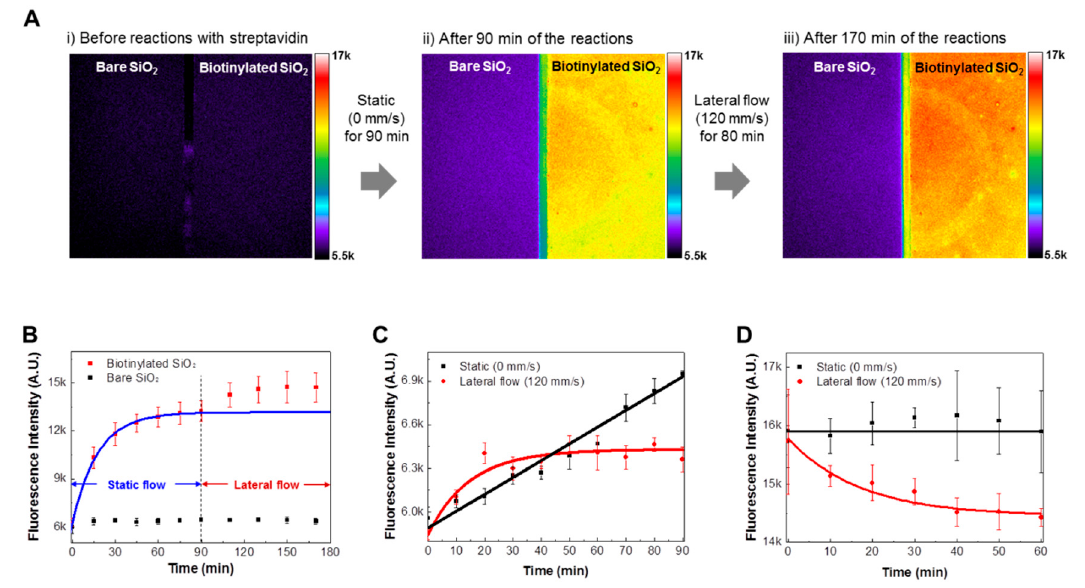
Figure 4. Reduced nonspecific adsorptions under lateral flow conditions: ( A ) ( i ) Fluorescence image of bare and biotinylated substrate before reaction with FITC-labeled streptavidin molecules, ( ii ) Fluorescence image of both substrates after 90 min reaction under static conditions, ( iii ) Fluorescence image of both substrates after 170 min reaction under static and lateral flow conditions. The experiment was performed under static conditions for 90 min, followed by under lateral flow conditions for 80 min; ( B ) Real-time response curves of the bare (black dot) and the biotinylated (red dot) substrates to FITC-labeled streptavidin molecules. The experiments were conducted under the experimental conditions of Figure 4A; ( C ) Nonspecific binding reaction curves of streptavidin molecules to bare SiO 2 substrates under static (black dot) and lateral (red dot) flow conditions; ( D ) Dissociation curves of nonspecifically bound streptavidin molecules to bare SiO 2 substrates under static (black dot) and lateral (red dot) flow conditions.